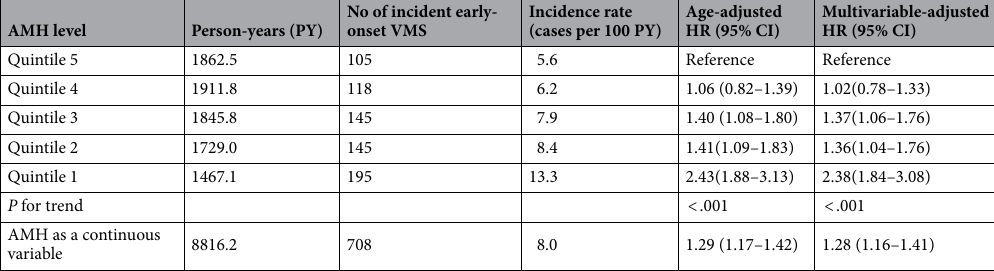
Table 2. Incidence of early-onset vasomotor symptoms by AMH quintiles in premenopausal women (n = 2041). Parametric proportional hazard models were used to estimate the hazard ratios with 95% confidence intervals. The multivariable model was adjusted for age, education level, parity, physical activity, smoking status, alcohol intake, hypertension, lipid lowering agent and body mass index. Abbreviation: AMH, anti-Müllerian hormone; CI, confidence interval; HR, hazard ratio.